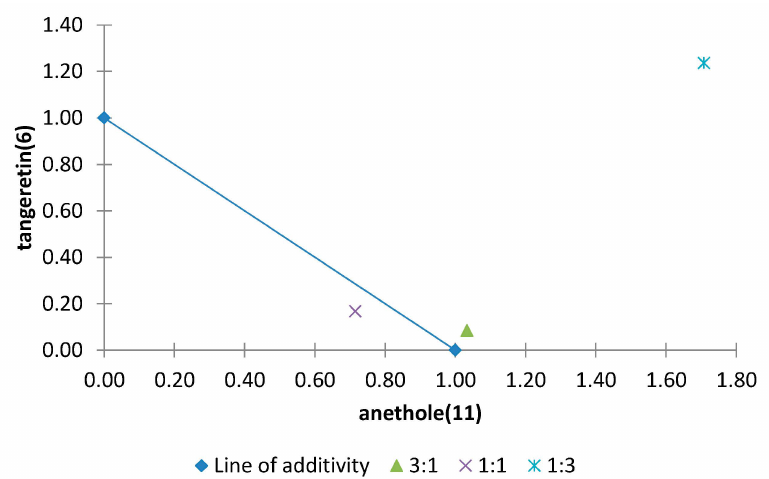
Figure 14. Normalized isobologram (ED 25 ) for binary mixtures of anethole ( 11 )/tangeretin ( 6 ) in the etiolated wheat coleoptile bioassay. (Combination ratios 3:1; 1:1; 1:3). The combination ratios 3:1